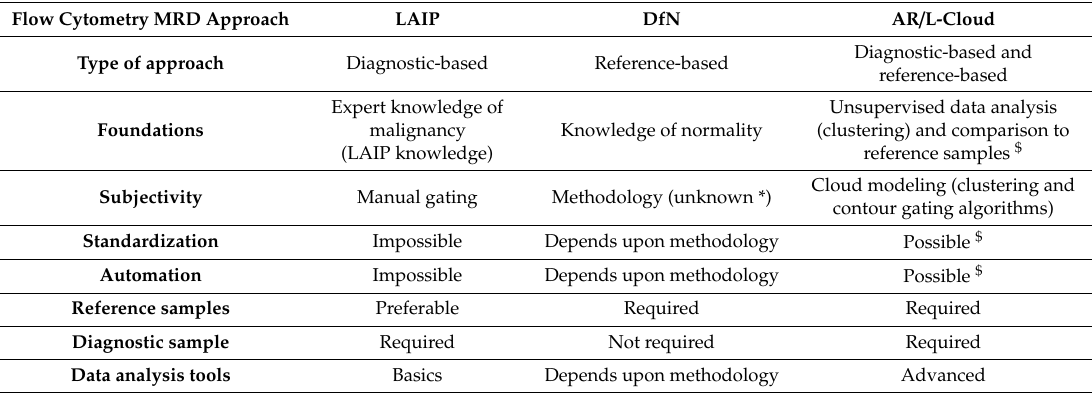
Table 3. Comparison of flow cytometry MRD